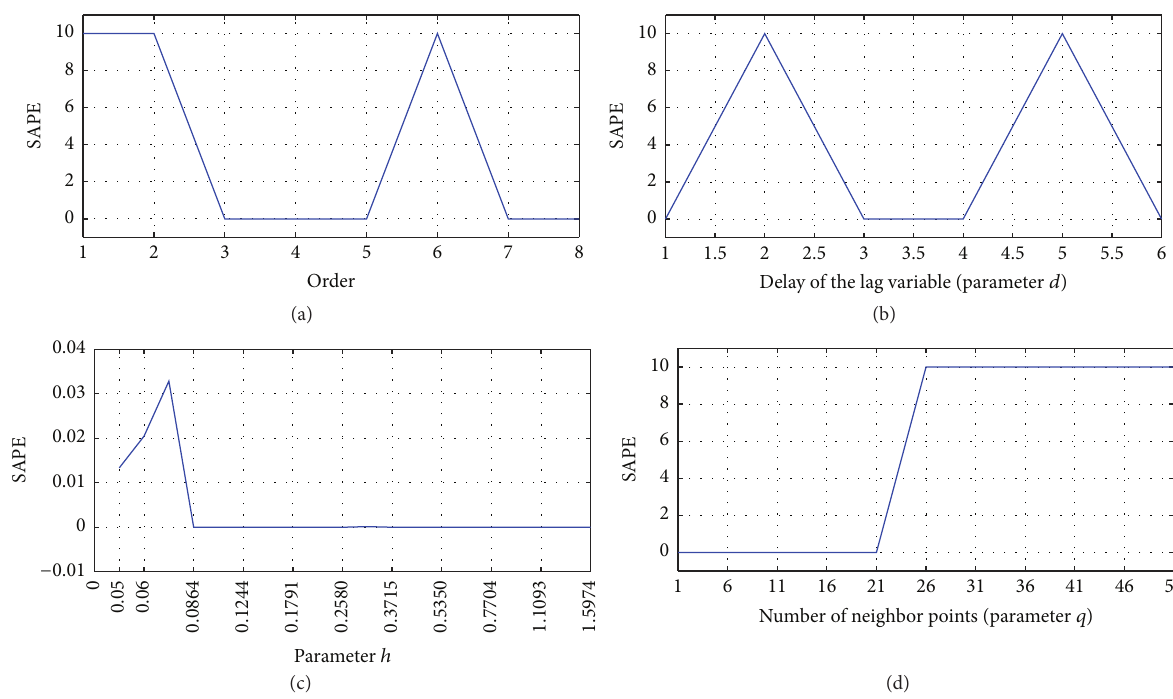
Figure 9: Multistep prediction results of Mackey-Glass time series: (a) the order of changed functional coefficients; (b) changed delay of the lag variable; (c) changed number of nearest neighbor points; (d) changed radius of the neighbors. Note: to speed up computation, we break off the computation when the prediction error values are large and set SAPE = 10